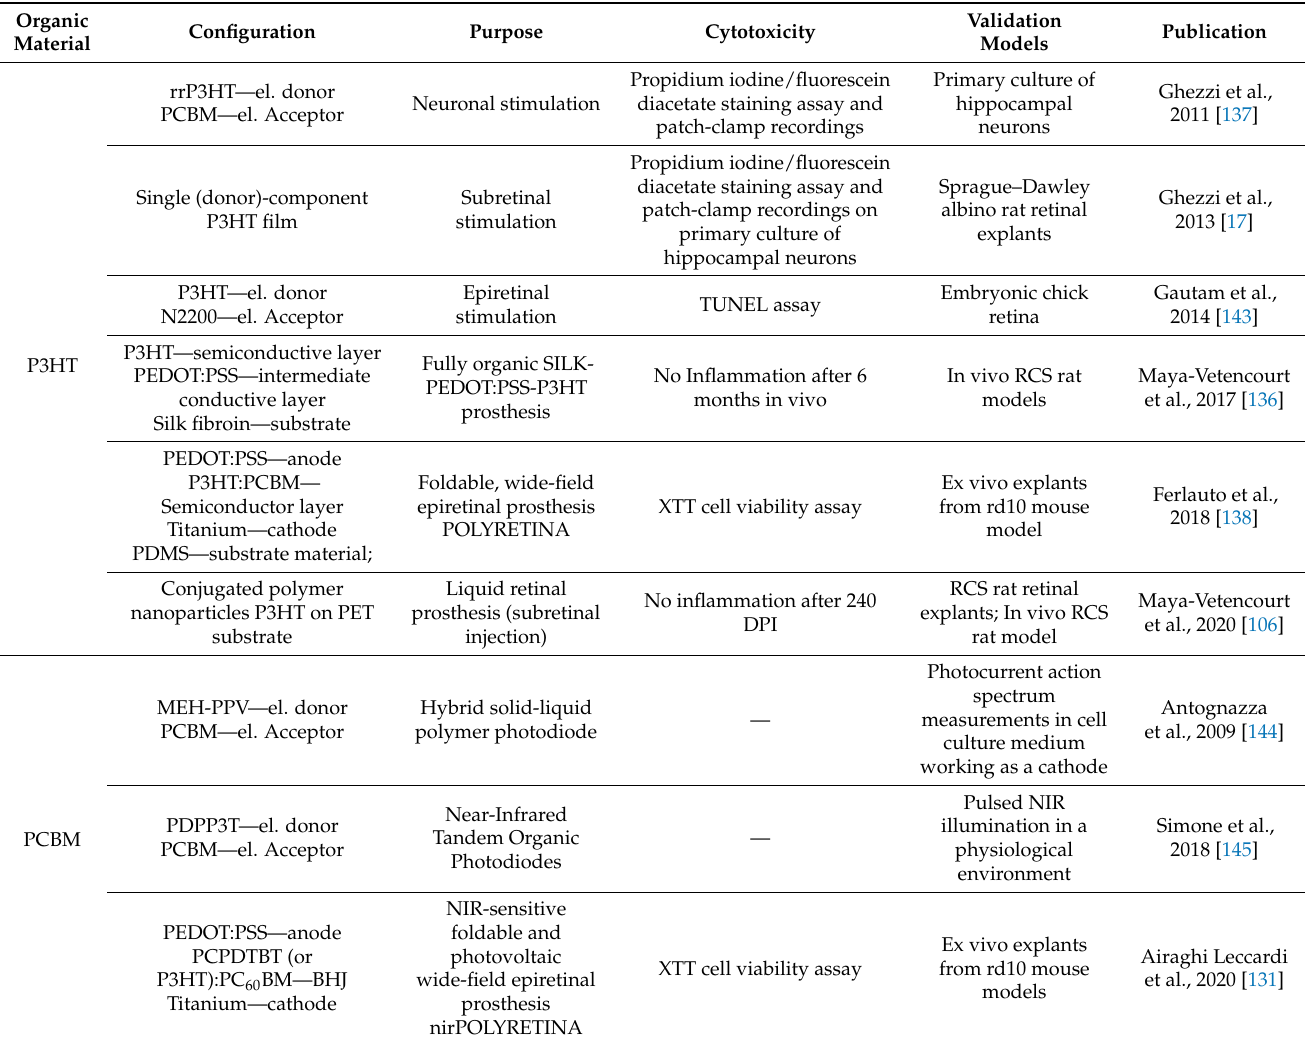
Table 3. Summary of the most-used organic materials in the field of organic retinal